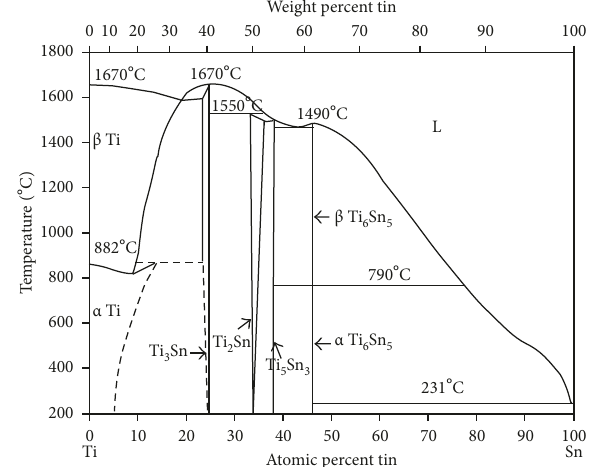
Figure 8: Phase diagram of Ti and Sn system (from Murray [30]).